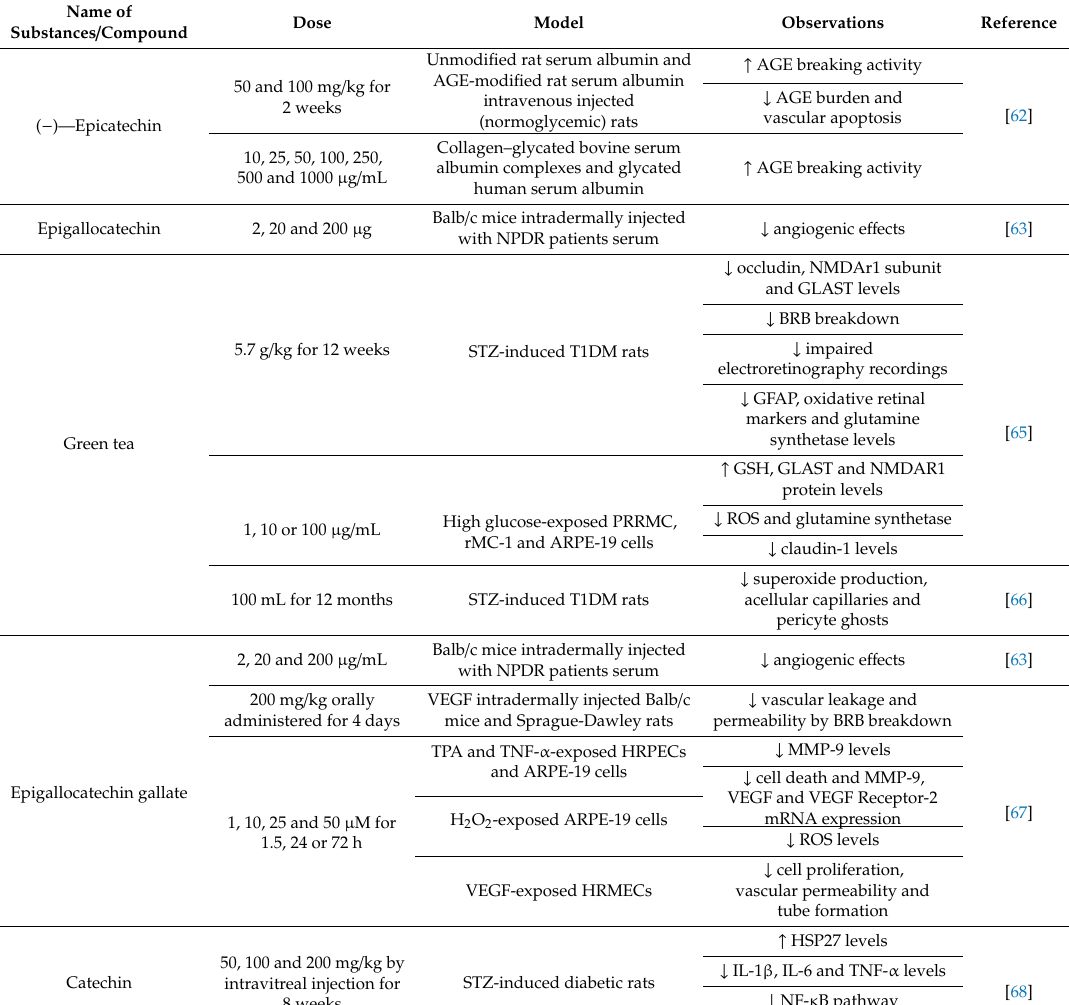
Table 2. E ff ects of flavanols on cellular and molecular mechanisms a ff ected by diabetic